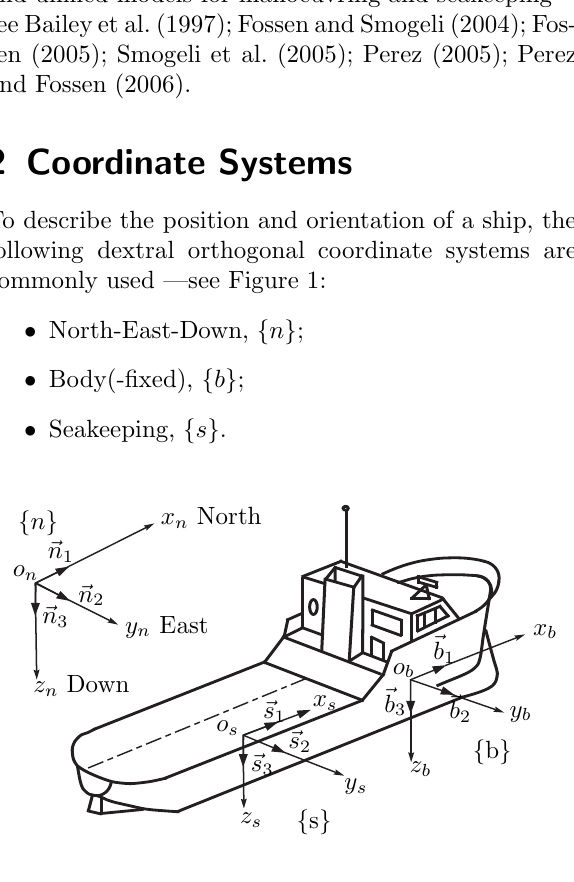
Figure 1: Coordinate systems used for ship motion de- scription.